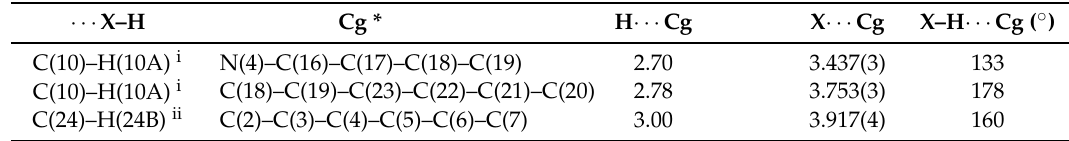
Figure 5. Crystal packing of 2 . Red dashed lines show the intermolecular C–H··· π interactions. Table 4. C–H··· π interaction geometry of compound 2 (Å, °).